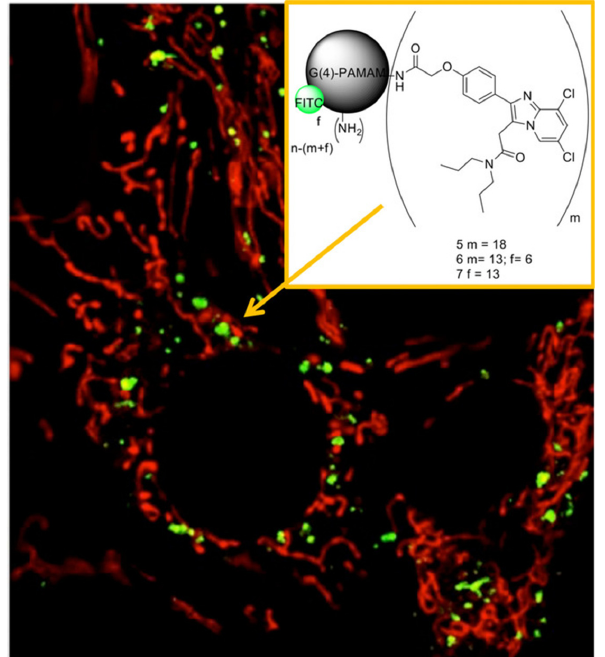
Figure 7. Representative confocal microscopy image of co-localization in a double-tagged C6 glioma cell (green: TSPO targeted-G(4)-PAMAM dendrimers grafted with FITC 1 µM; red: mitochondrion tagged with MitoTracker Red; yellow: convergence of red and green, indicating co-localization). Insert: TSPO ligand molecule and the TSPO-